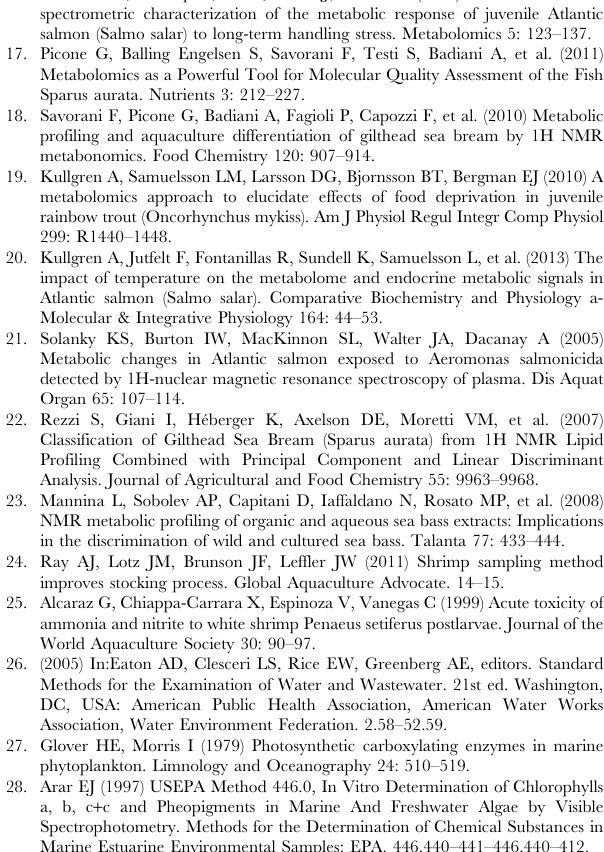
Table S3 Significant shrimp metabolite changes